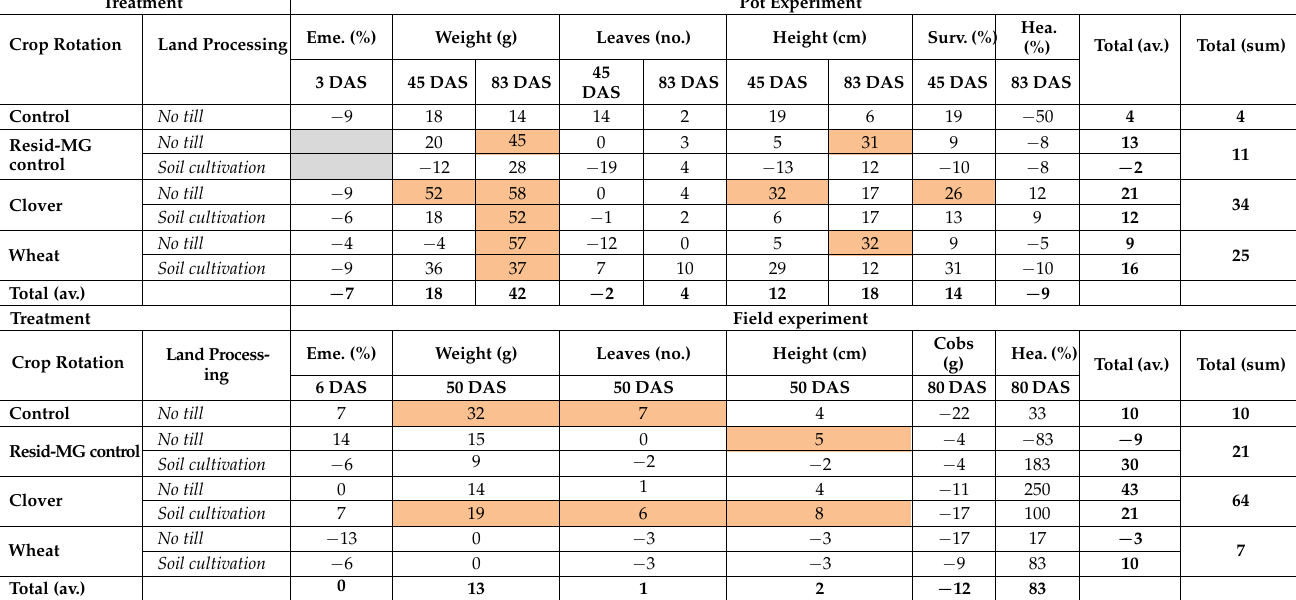
Table 5. Comparative analysis of the greenhouse and field experiments results 1 .